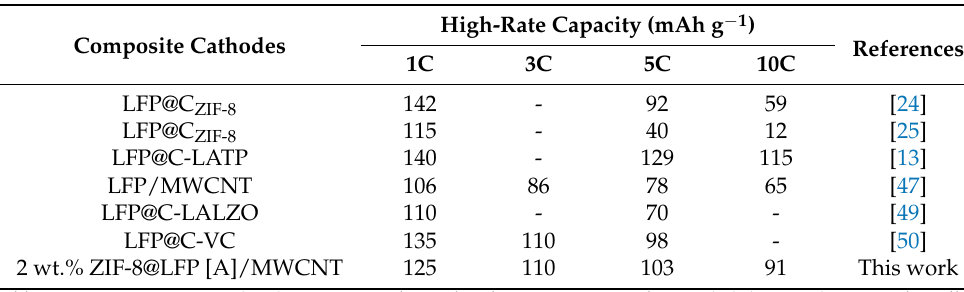
Table 1. Comparison of the high-rate performances 2 wt.% ZIF-8@LFP [A]/MWCNT composite cathode with previous